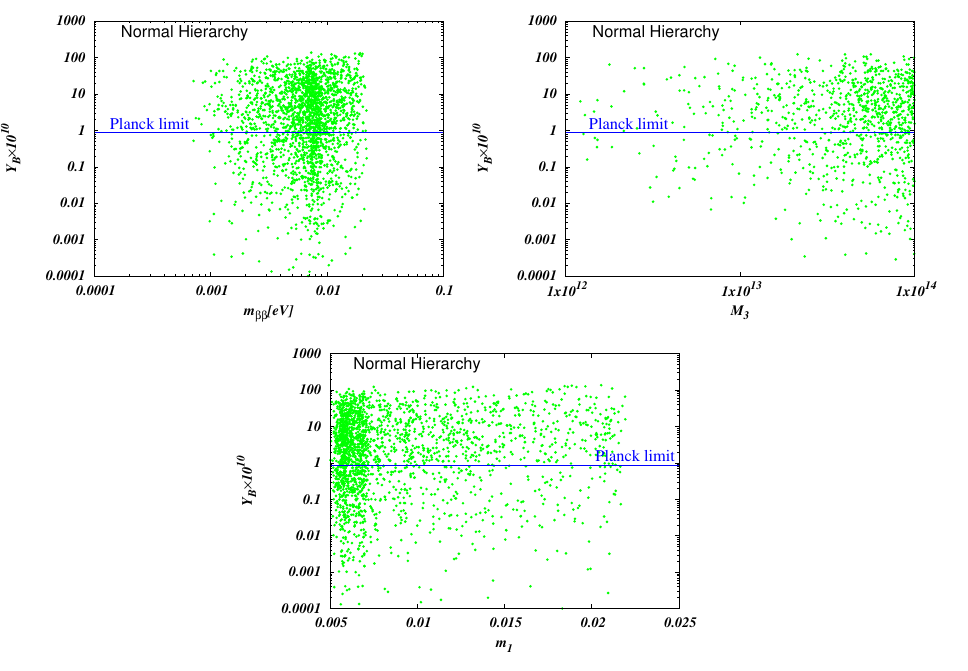
Figure 7 . The baryon asymmetry Y B as a function of the effective Majorana mass m ββ (top left), the lightest RH neutrino mass M (top right) and the lightest neutrino mass m 3 horizontal blue line corresponds to the Planck